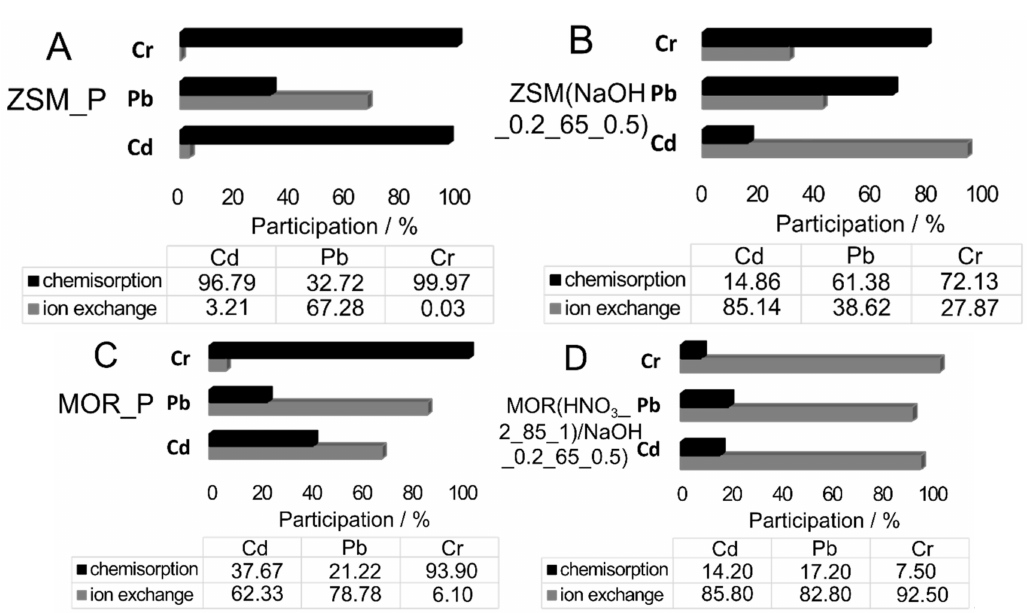
Figure 8. Comparison of chemisorption and ion-exchange processes involving the analyzed cations on studied materials (( A ): ZSM_P; ( B ): ZSM(NaOH_0.2M65_0.5 M); ( C ): MOR_P and ( D ): MOR(HNO 3 _2_85_1 / NaOH_0.2 M_65_0.5) for the initial concentration of 20 mmol / dm 3 of